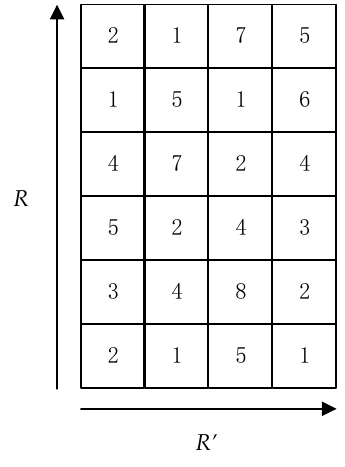
Figure 5. Similarity matrix.